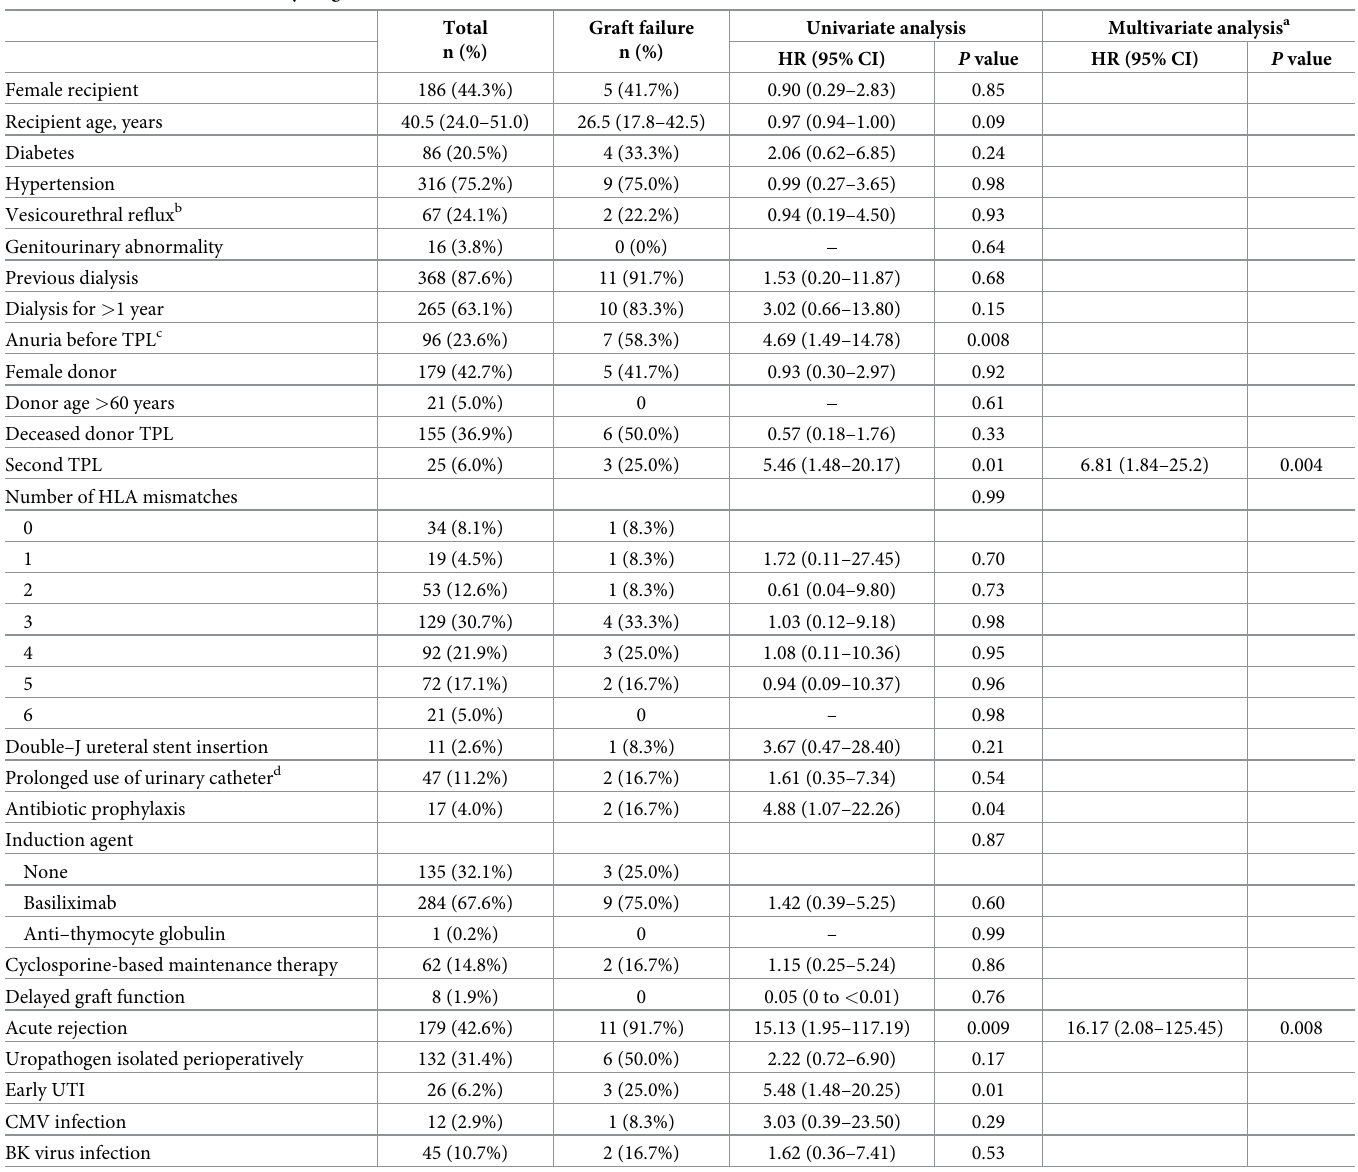
Table 4. Factors associated with 5-year graft